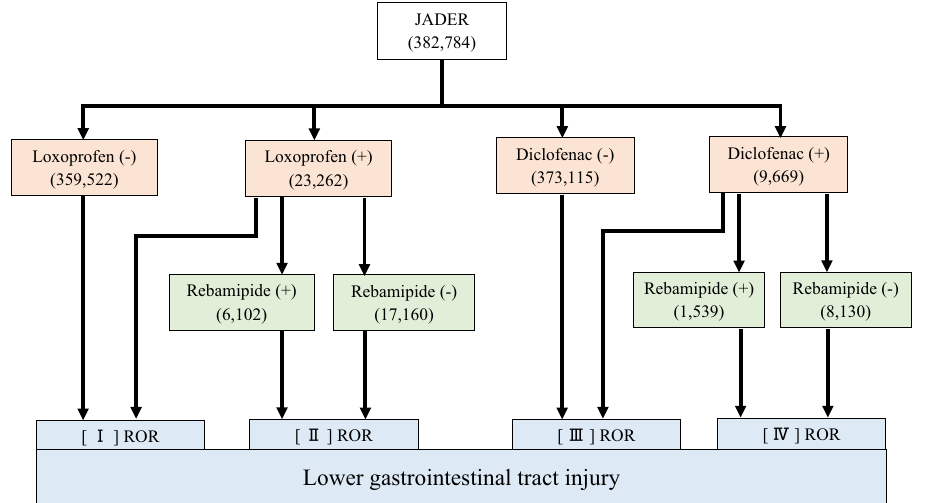
Figure 2. Flow chart summarizing the determination of RORs for lower gastrointestinal tract injury categorized according to drug usage in JADER. Numbers in parentheses indicate the number of adverse drug reactions reported. [I] ROR shows the odds ratio of lower gastrointestinal tract injury for loxoprofen alone and for drugs excluding loxoprofen. [II] ROR shows the odds ratios for loxoprofen with and without rebamipide. [III] ROR shows the odds ratio of lower gastrointestinal tract injury for diclofenac alone and for drugs excluding diclofenac. [IV] ROR shows the odds ratios for diclofenac with and without rebamipide.